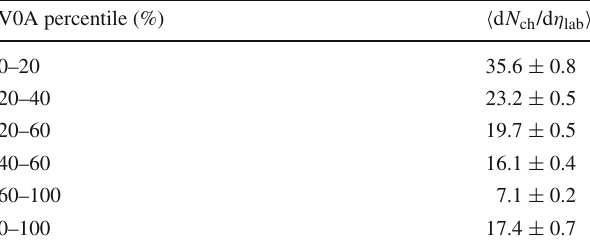
Table 1 Mean charged-particle multiplicity densities ( (cid:3) d N ch /d η lab (cid:4) ) measured at midrapidity ( | η lab | < 0 . 5) [23], corresponding to the mul- tiplicity classes defined using the V0A detector [25] in p–Pb collisions √ s at